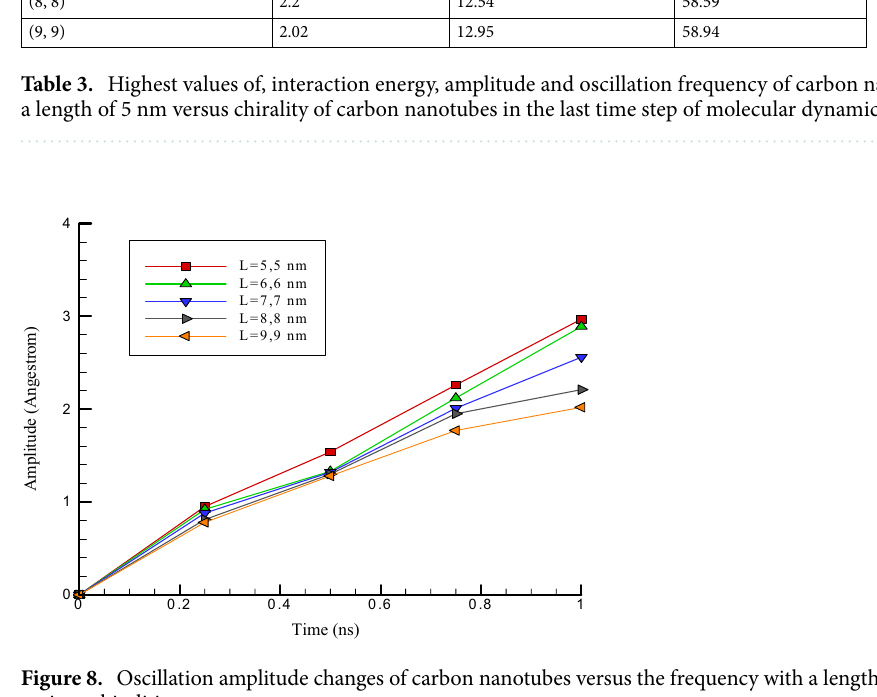
Figure 8. Oscillation amplitude changes of carbon nanotubes versus the frequency with a length of 5 nm in variuos